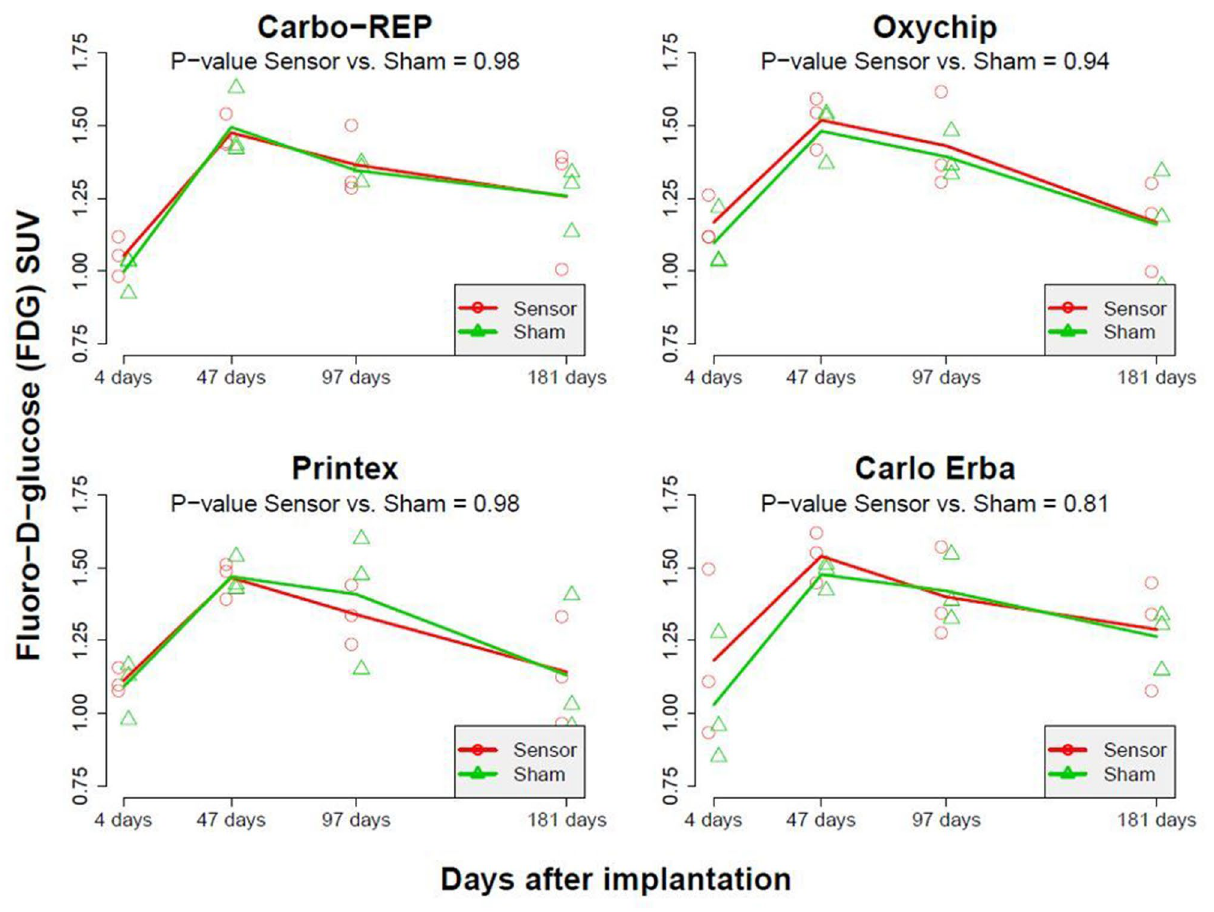
Figure 3. FDG SUV mean values for sham and sensor in rat muscles as measured by PET at 4, 47, 97 and 181 days after sensor administration. For all four types of oxygen sensors no significant difference in FDG SUV mean was found between the sensor-implanted muscles and sham muscles across all time